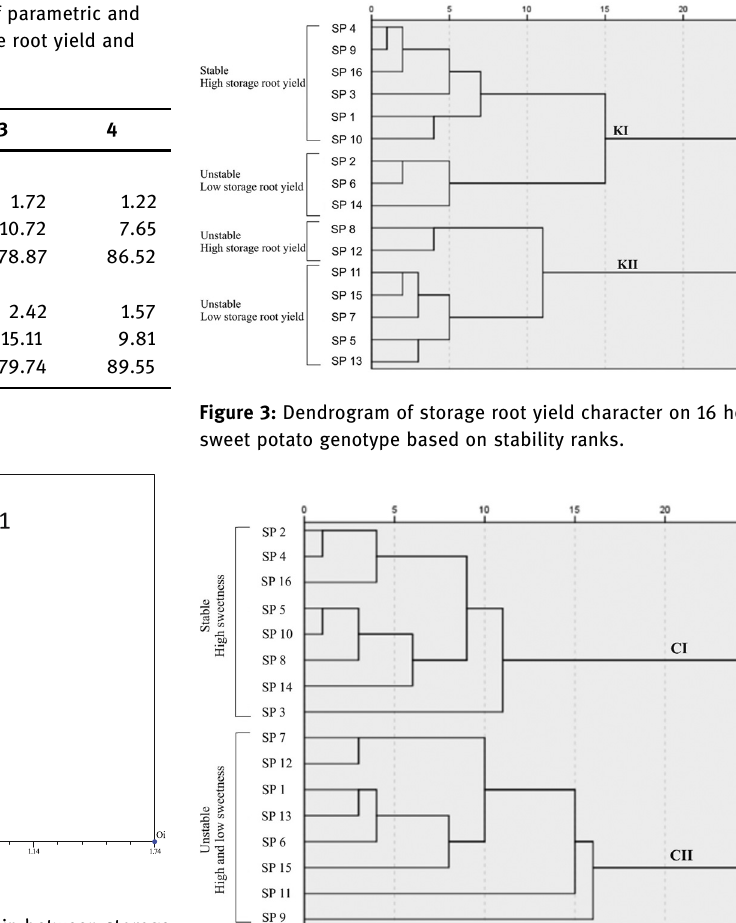
Figure 1: PCA biplot for depicting the relationship between storage root yield and numerical stability measurements in 16 genotypes of honey sweet potato at six locations in West Java, Indonesia.